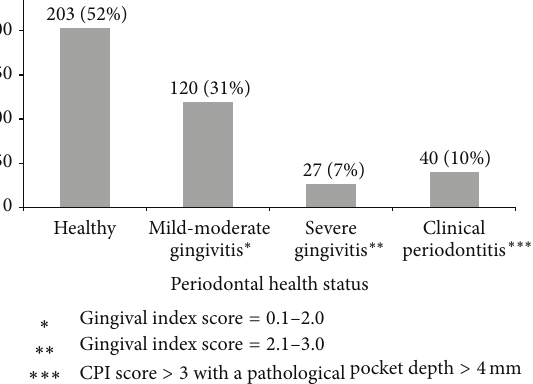
Figure 1: Periodontal health status based on CPI scoring system among study population.